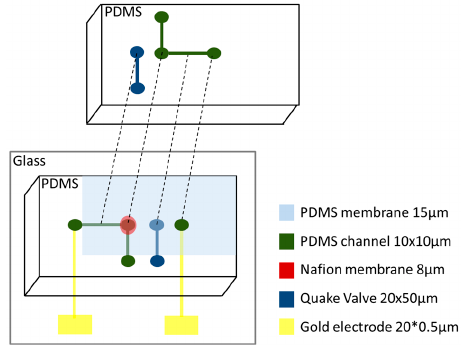
Figure 11. Different layers of the microfluidic neuron.